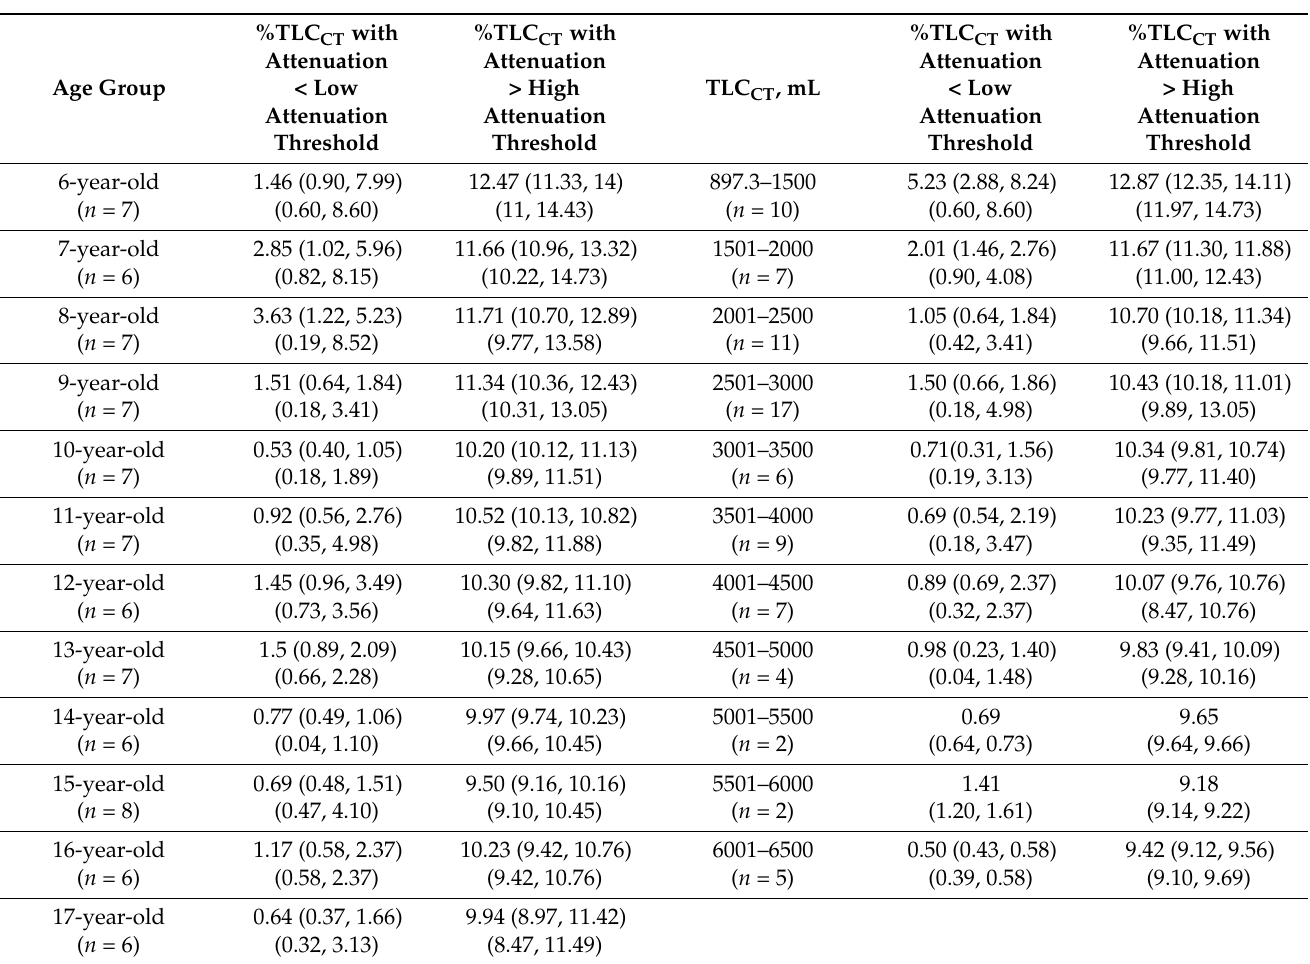
Table 2. Values of %TLC CT with low or high attenuation for individual subjects summarized according to age group and TLC CT